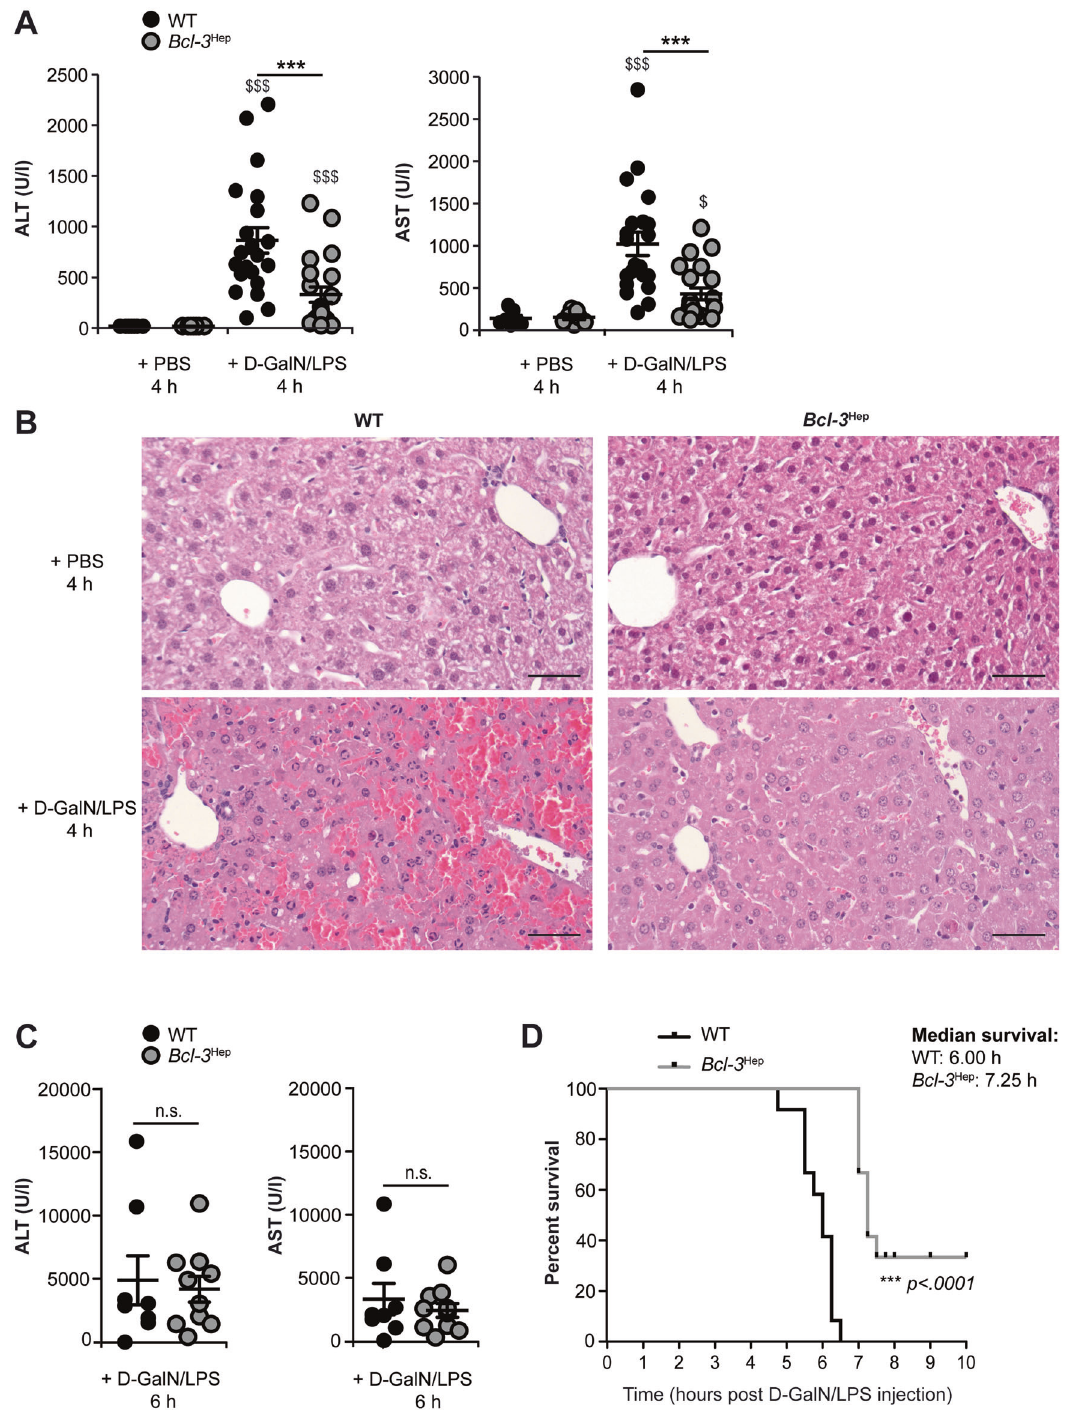
Fig. 1 Conditional overexpression of Bcl-3 in hepatocytes mitigated liver injury from d-GalN/LPS and promoted survival of mice. Liver injury following treatment with d-GalN/LPS was assessed by measurement of A serum alanine and aspartate aminotransferase (ALT and AST) levels, and B standard H&E staining of liver sections (scale bar: 50 µm, representative histological photomicrographs) in Bcl-3 Hep and WT mice at 4 h. C Serum transaminases in Bcl-3 Hep and WT mice at 6 h post d-GalN/LPS. D Kaplan – Meier survival plots for Bcl-3 Hep and WT mice after d- GalN/LPS injection. Data in A represent means ± SEM from four experiments with a total of n = 21 WT + d-GalN/LPS, n = 21 Bcl-3 Hep + d-GalN/ LPS, n = 7 WT + PBS and n = 7 Bcl-3 Hep + PBS. Data in C represent means ± SEM of n = 10 mice/group, whereby 20% of the WT + d-GalN/LPS group was already dead at this time point. In D survival rate was monitored for 8 h after injection of d-GalN/LPS in a total of n = 12 WT and n = 10 Bcl-3 Hep mice. *** p < 0.001 for WT vs. Bcl-3 Hep and $ p < 0.05, $$$ p < 0.001 for PBS vs. d-GalN/LPS using Mann – Whitney U test ( A and C ) or a log-rank test ( D ). In C there was no statistical difference between the two groups in respect of the parameters.